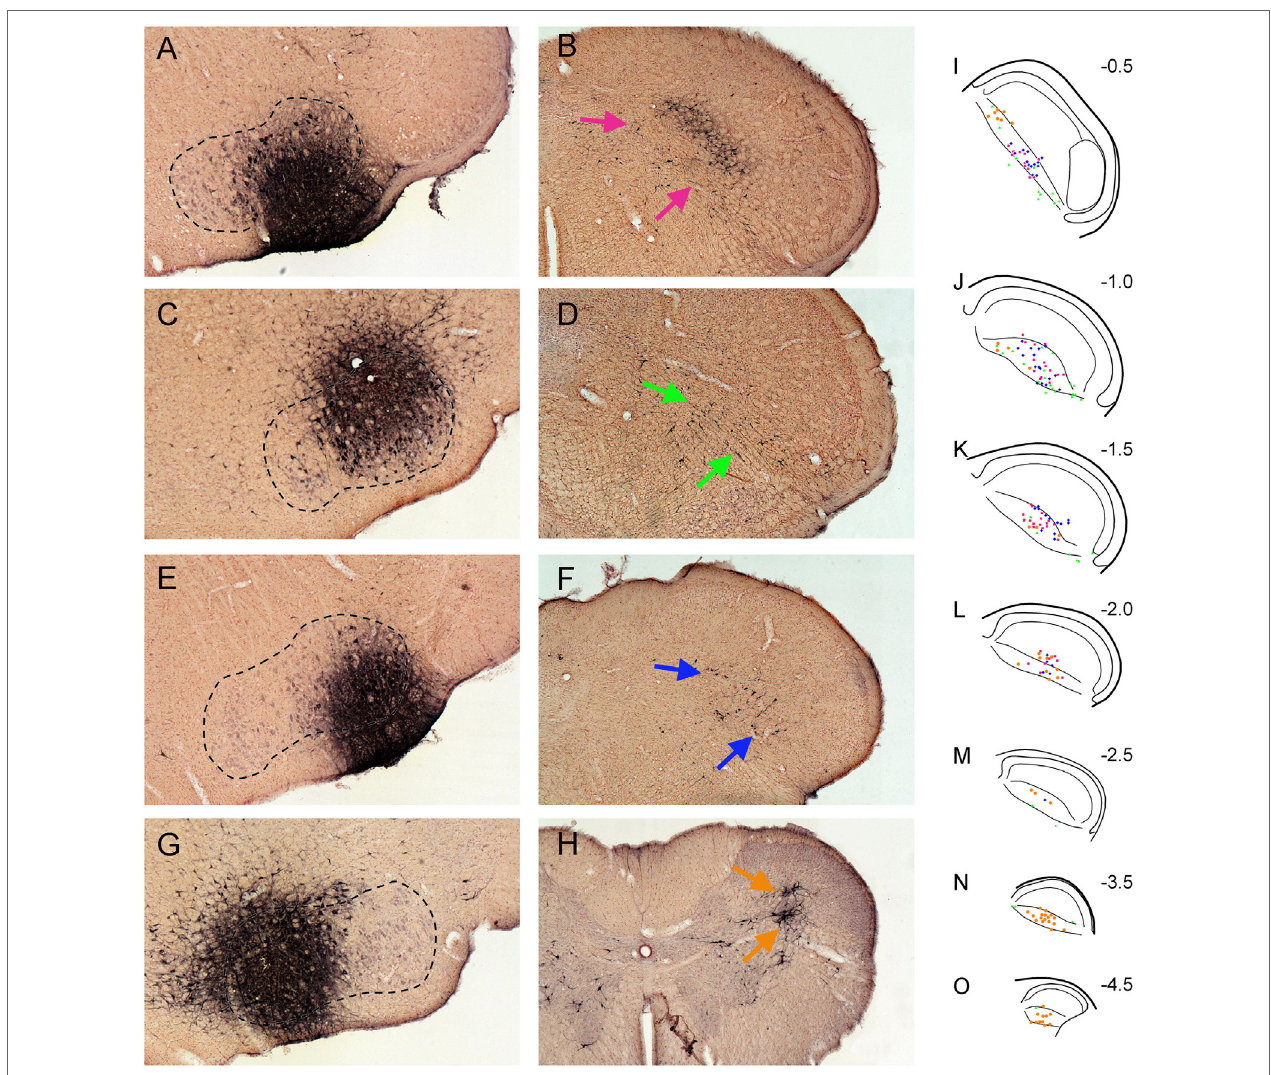
FigUre 3 | Bright field photomicrographs showing FluoroGold injections into intermediate (a) , dorsolateral (c) , ventrolateral (e) , and medial (g) parts of the facial motor nucleus and its subsequent retrograde transport into the trigeminocervical complex [ (B) pairs with (a) , (D) with (c) , (F) with (e) , and (h) with (g) ]. Note that almost all retrograde labeling in the medullary dorsal horn (MDH) from these cases was found in lamina V [arrows (B,D,F,h) ]. (i–O) are composite line drawings showing the differential distribution of retrograde labeling in lamina V after injections of intermediate (red squares), dorsolateral (green triangles), ventrolateral (blue diamonds) and medial (orange circles) parts of the facial motor nucleus. These areas represent functional groups of motoneurons innervating lip musculature, periocular muscles, snout muscles, and periauricular muscles, respectively. Note that neurons retrogradely labeled after intermediate facial injections generally are found centered in lamina V in the rostral half of the MDH, those from dorsolateral injections are found ventrally in the rostral third of the MDH, those from ventrolateral injections are centered in its rostral half, while those from medial injections are mostly in the caudal half of the trigeminocervical complex, but with a few in dorsal rostral parts. Numbers in (i–O) indicate millimeters caudal to the obex. We propose that such retrogradely labeled neurons are important interneurons in simple disynaptic reflex